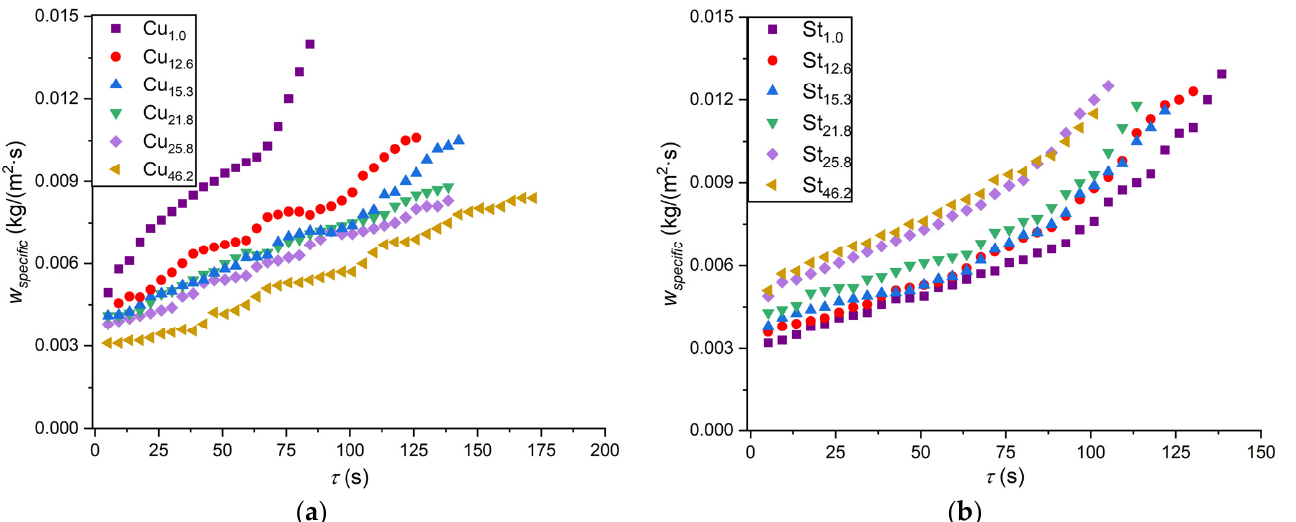
Figure 6. Specific evaporation rate versus evaporation time of water droplets from copper ( a ) and steel ( b ) surfaces heated to 80 °C at an ambient temperature of 23 ° С .